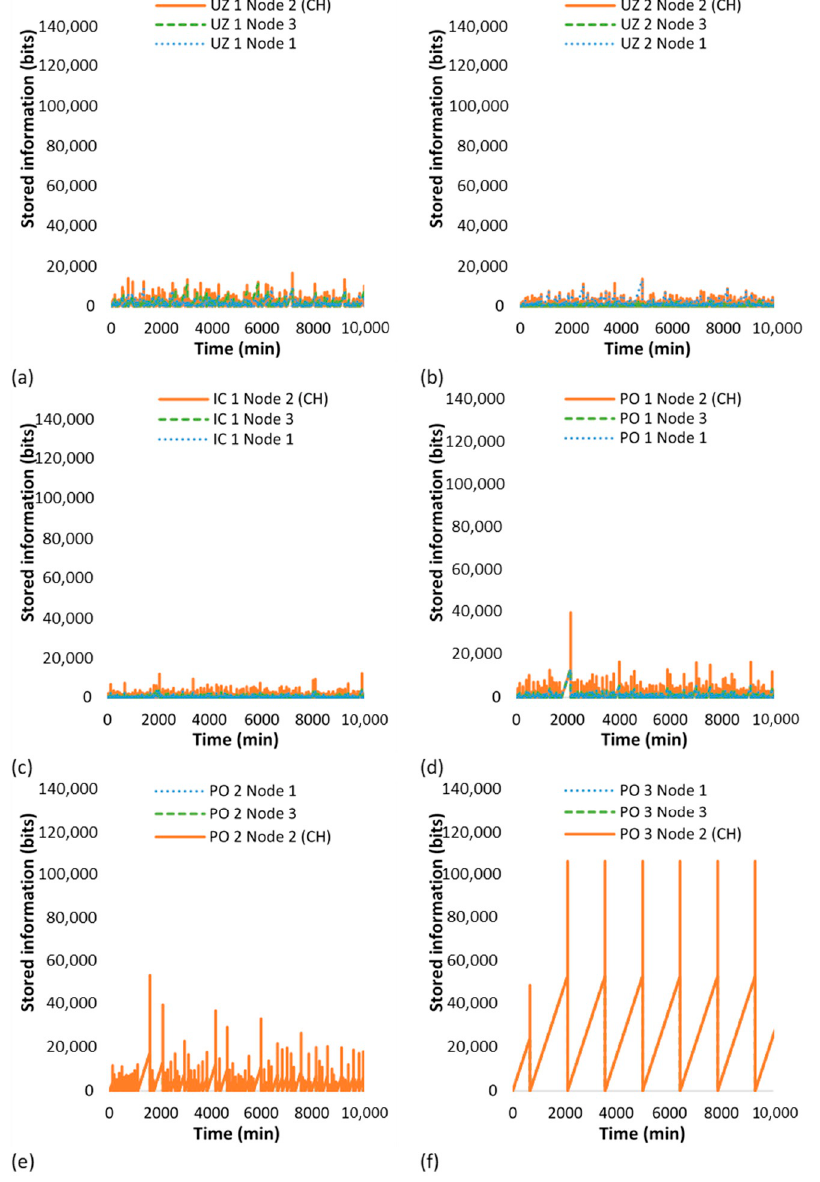
Figure 11. Stored information in the SDs cards of nodes. Summary of the whole simulated period. Different letters ( a ) to ( f ) denote different locations of the cluster: ( a ) UA1, ( b ) UA2, ( c ) IC1, ( d ) PO1, ( e ) PO2, and ( f ) PO 3.